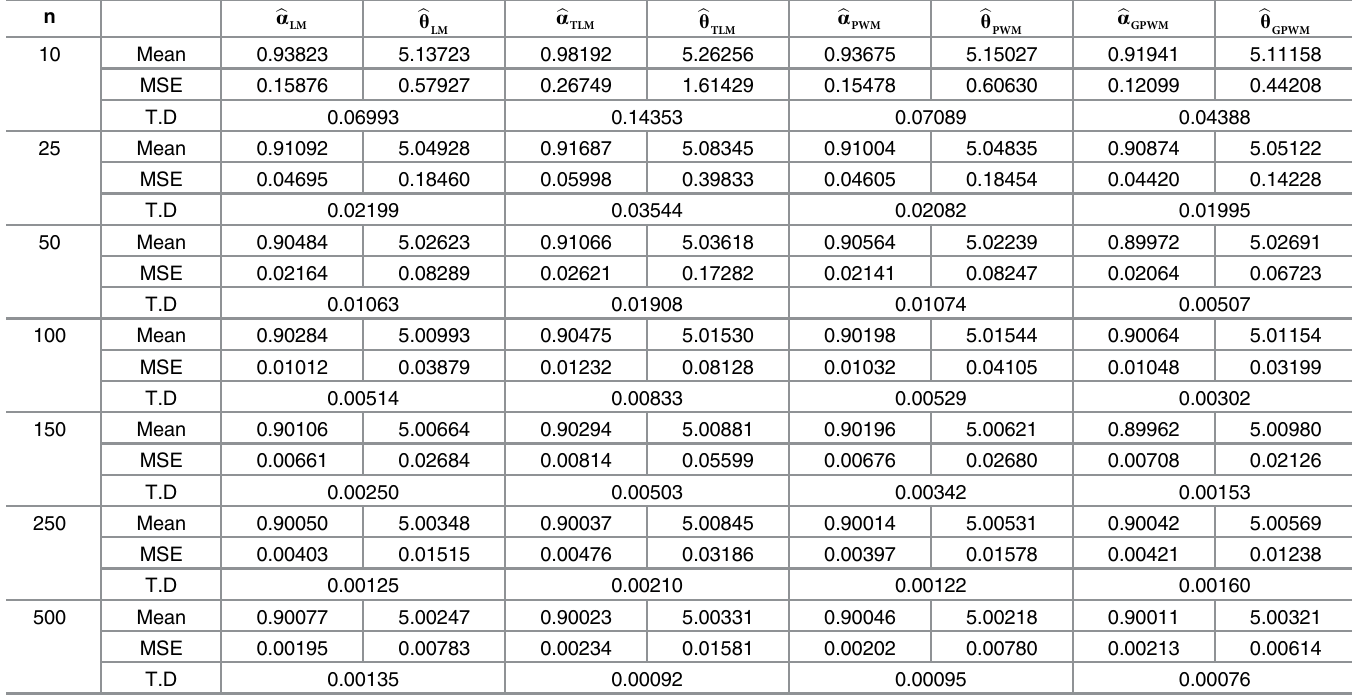
Table 3. Comparison of the estimation methods for ( α = 0.9, θ =